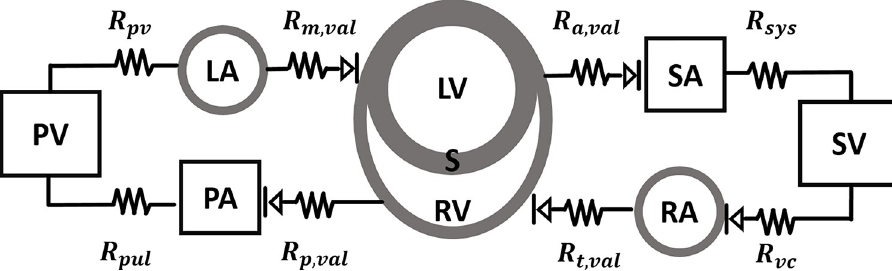
Fig 1. Model schematic. The computational model here consists of a lower order simulator of sarcomere dynamics within the left atrium (LA), left ventricle (LV), right atrium (RA), right ventricle (RV), and septum (S). The LV, RV, and S are simulated using the TriSeg model [8], and account for biventricular interaction. Lastly, a circuit model is used to describe the systemic arteries (SA) and veins (SV), as well as the pulmonary arteries (PA) and veins